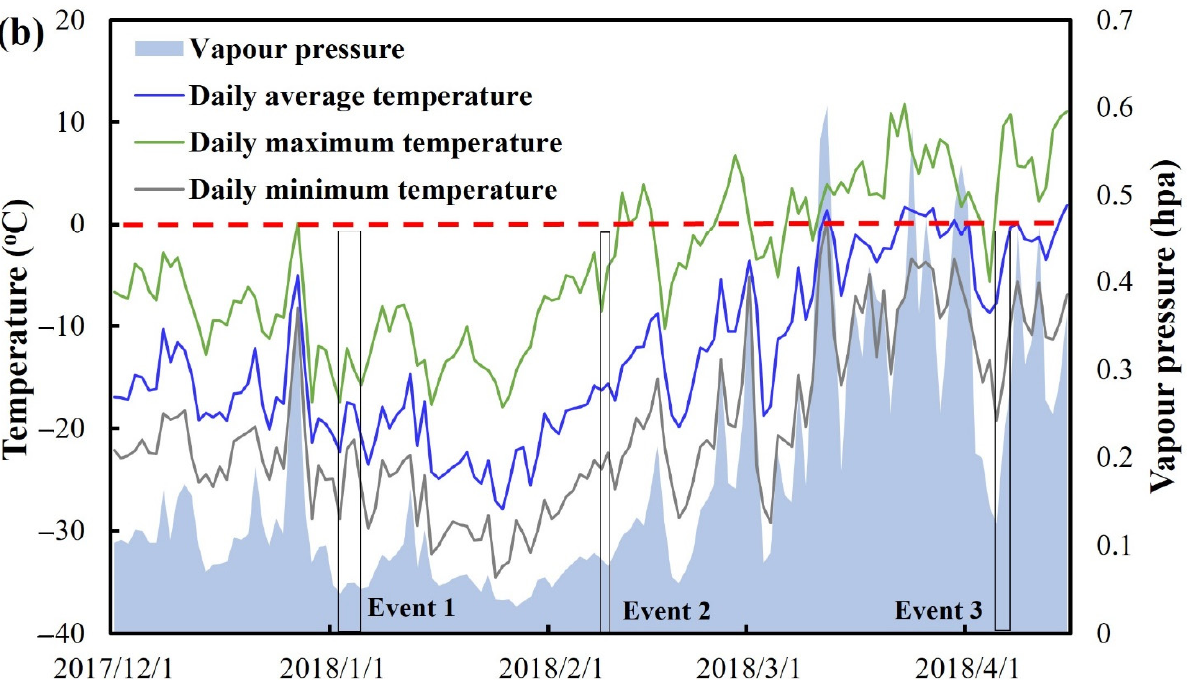
Figure 2. Meteorological condition observed by Kayier snowdrift observation site from December 1 2017 to April 15 2018: ( a ) daily precipitation and snow depth; ( b ) daily average, maximum, and minimum temperature and vapor pressure.